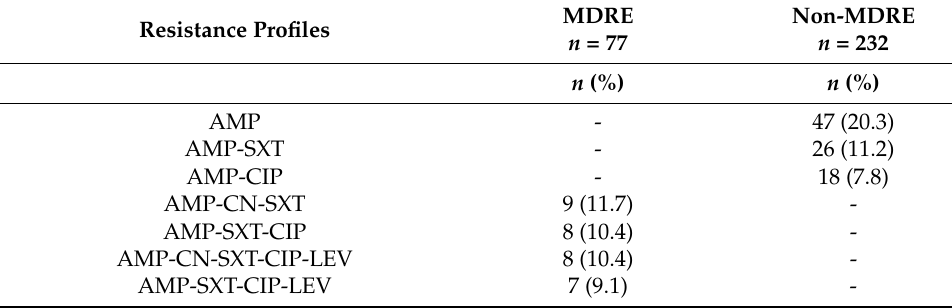
Table 4. Common resistance profiles among MDRE and